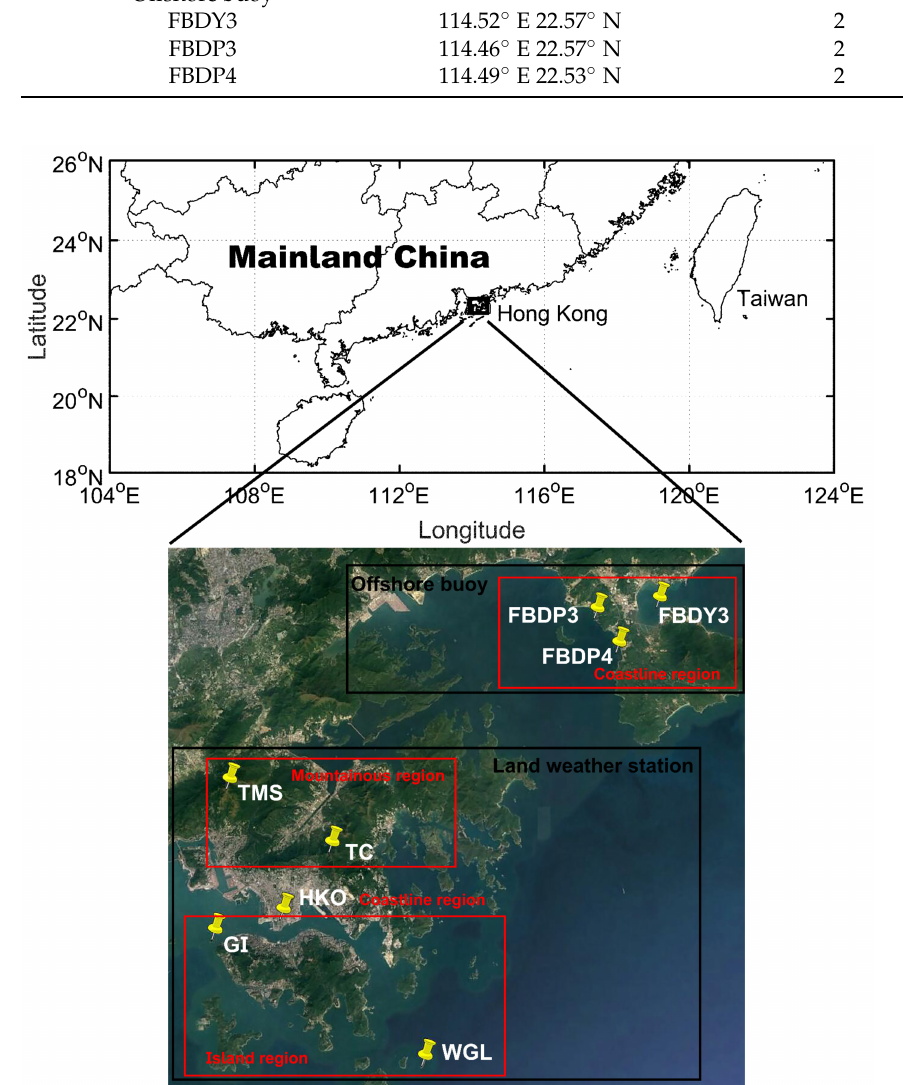
Figure 2. Locations of the five land weather stations and the three offshore